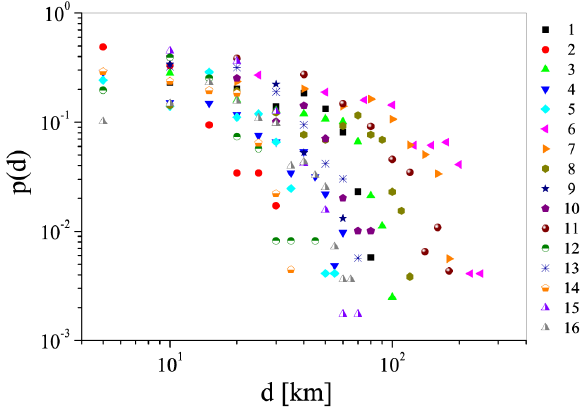
Figure 1 . Frequency distribution p ( d ) of the spatial distances versus distance value d , for the epicenters of the earthquakes listed in Table